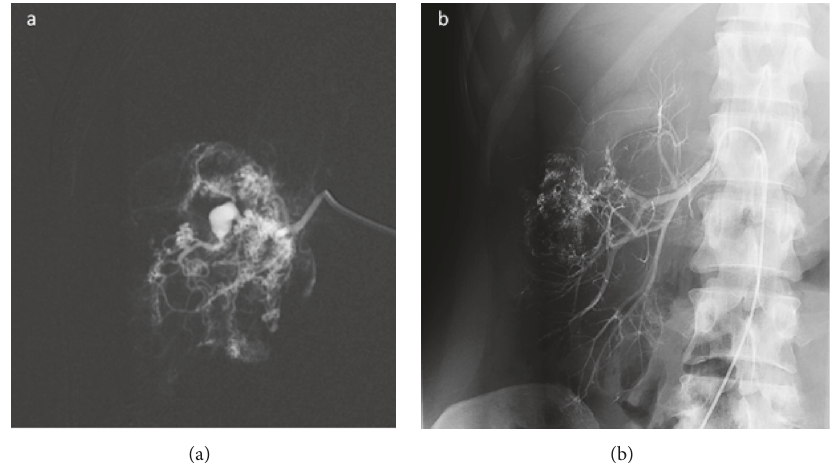
Figure 2: Angiography of the right kidney angiomyolipoma’s (AML) pseudoaneurysm (PSA): (a) patent PSA and feeding vessel of the AML before endovascular closure; (b) occluded PSA feeding vessel of the AML.